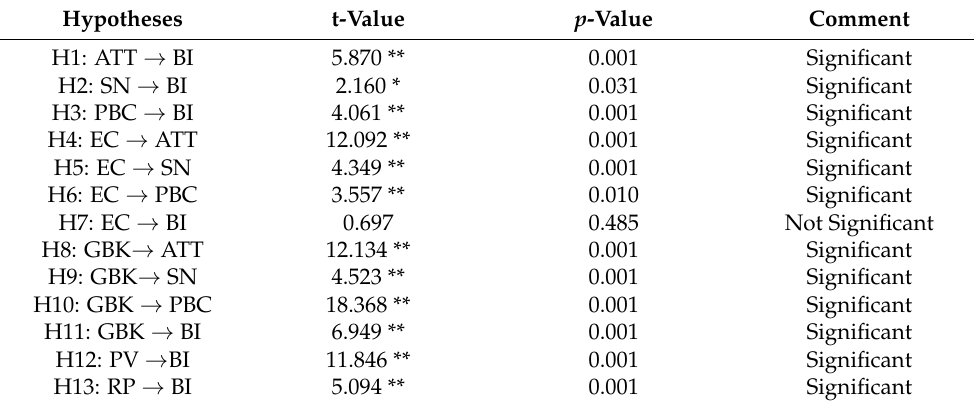
Figure 2. Structural model. Table 5. Results of hypothesis